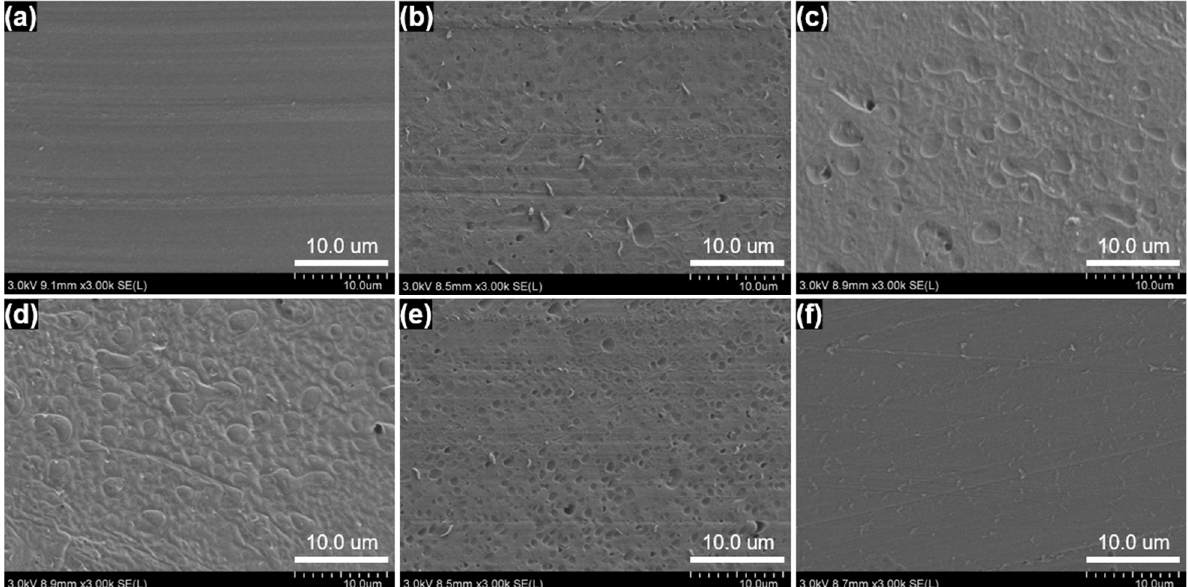
Figure 4. SEM images of TPU, TPU/PLA blends, and PLA: ( a ) TPU, ( b ) 80/20, ( c ) 60/40, ( d ) 40/60, ( e ) 20/80, and ( f ) PLA.